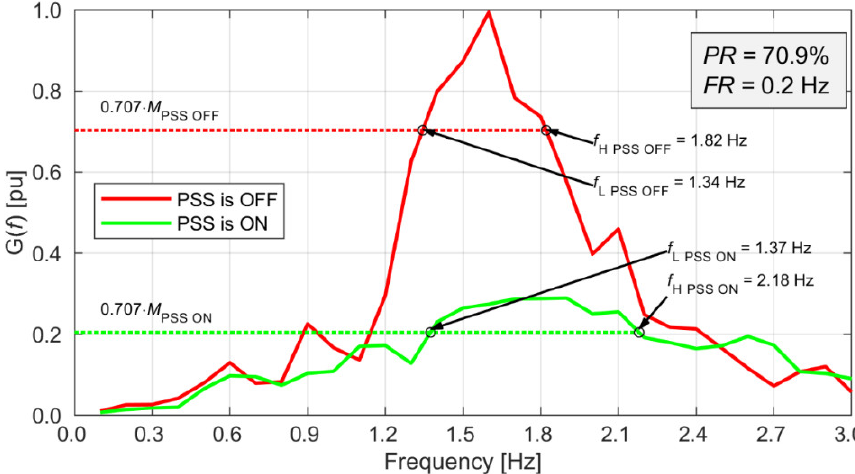
Figure 14. G PSS OFF ( f ) and G PSS ON ( f ), P g = 370 MW, Q g = 5 Mvar [41].